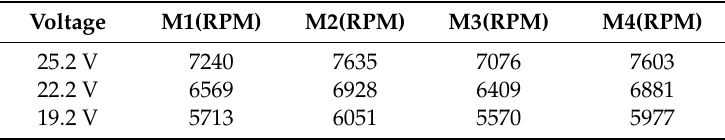
Table 3. Maximum RPM of each motor with di ff erent